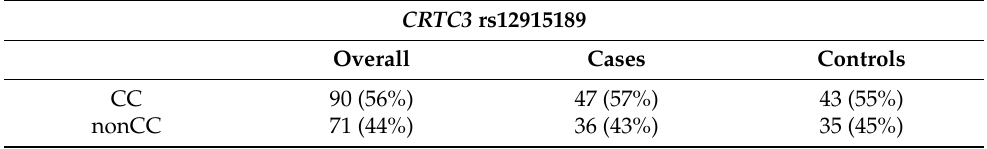
Table A4. Numbers of CRC cases and healthy controls depending on CRTC3 gene polymorphism